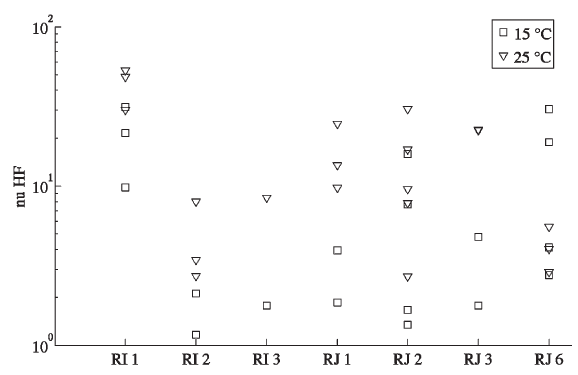
Figure 1. High frequency power of heart rate variability analysis for each specimen at both temperatures. Normalized high frequency power (nu HF, in log scale) obtained through power spectrum density analysis for 3 Rhinella icterica (RI 1-3) and 4 Rhinella jimi (RJ 1-3 and 6). Squares denote that the data were obtained at 15 6 C whereas triangles indicate results at 25 6 C.